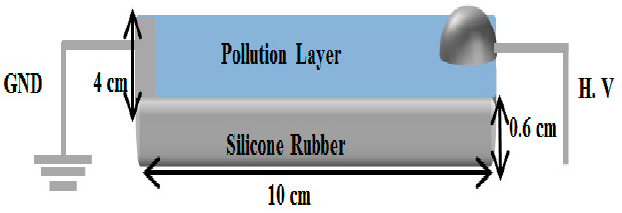
Figure 2. Test sample showing electrode setup and sample dimensions.